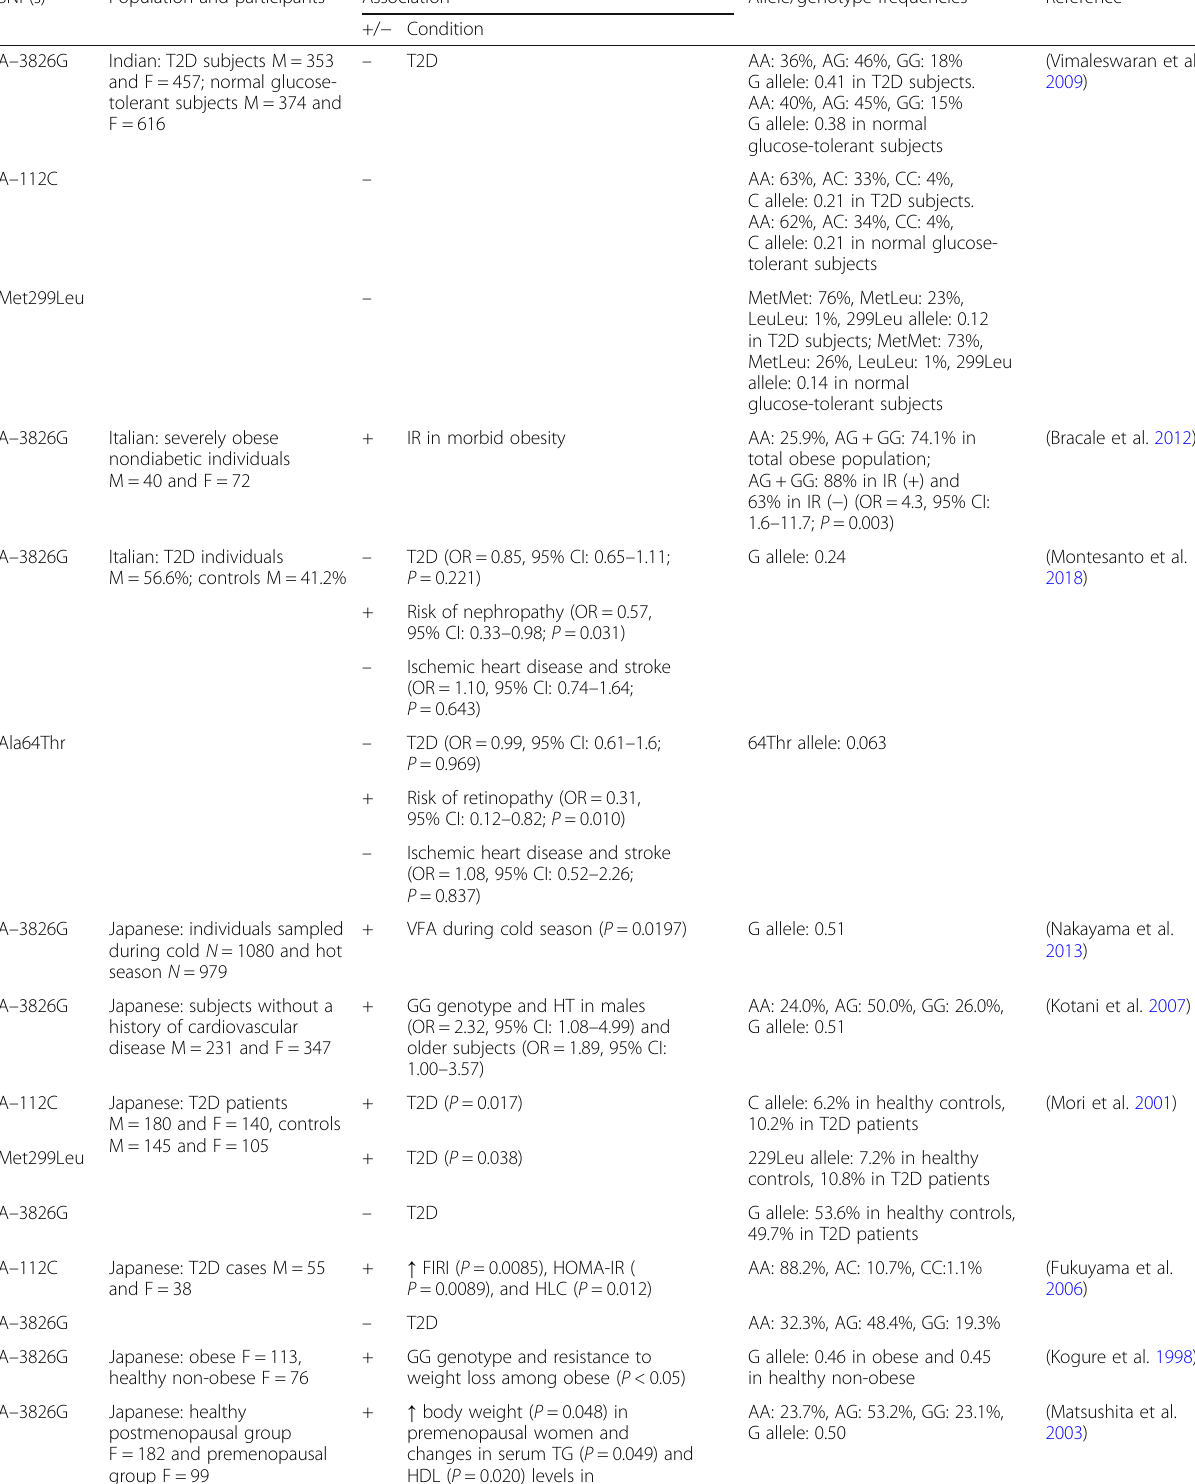
Table 1 Studies on the association between the Ucp1 polymorphisms and CMDs or CMD risk factors in different populations (Continued) SNP(s) Population and participants Association Allele/genotype frequencies Reference +/ −